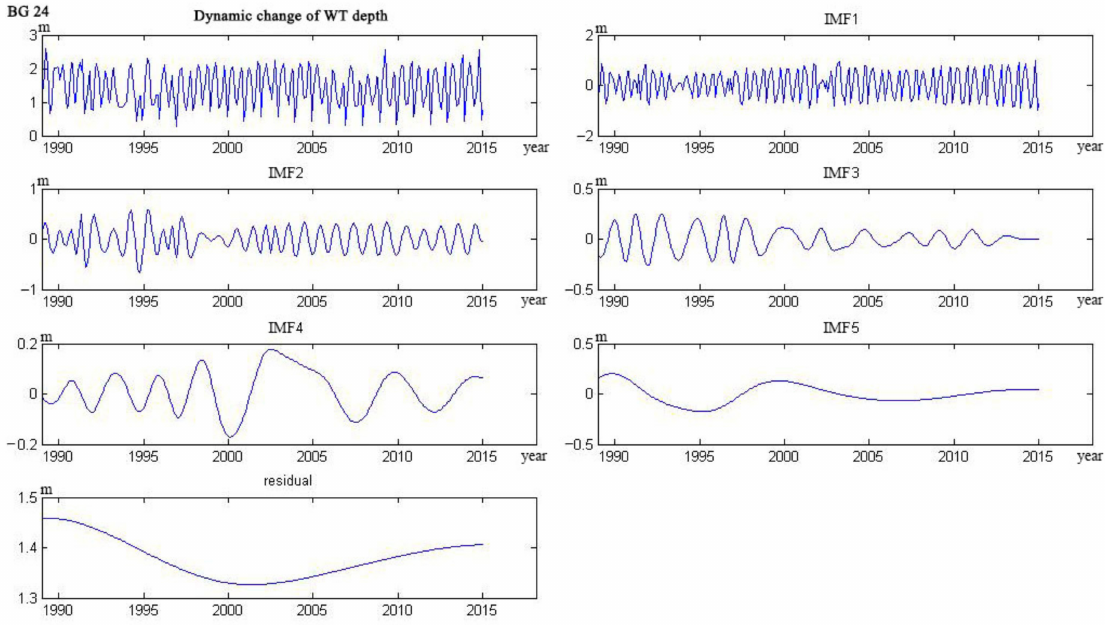
Figure A16. Decomposition of groundwater time series data of well